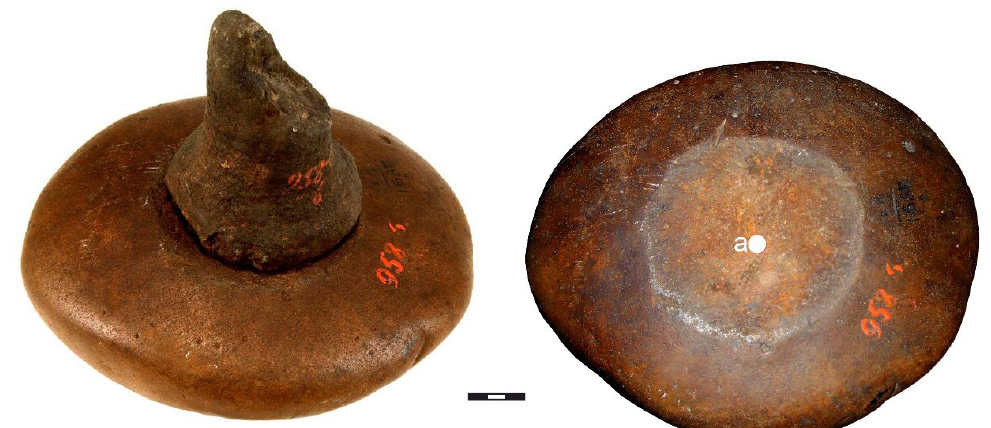
Figure 11. Ethnographic tool (lower stone and mano) for grinding berries and grains (MAE RAS No. 958-6 / a- b). Cheyenne, Wyoming, USA, Late 19th century (scale bar = 1 с m). The white spot indicates the location from which the micro-photo was taken (see Figure 12).